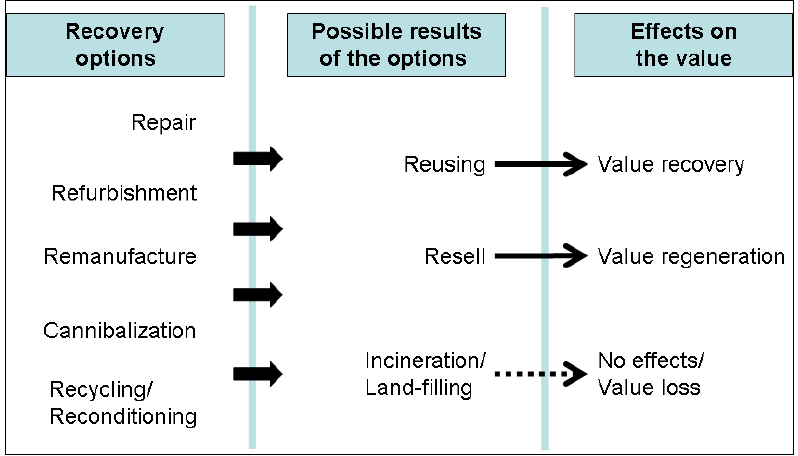
Figure 2: Options for Recovery and Implications for the Value of Returns